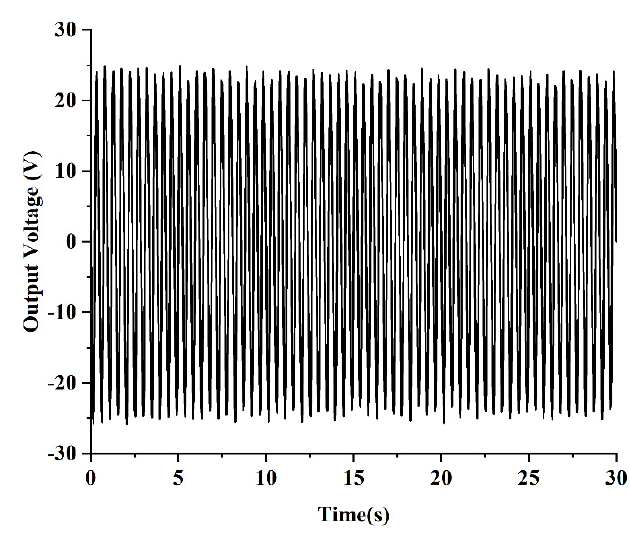
Figure 16. Residency